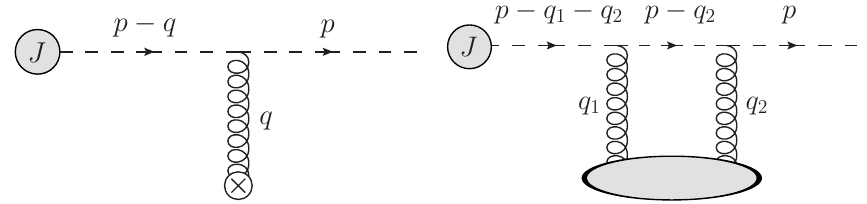
(left) and double-Born (DB) amplitude 1